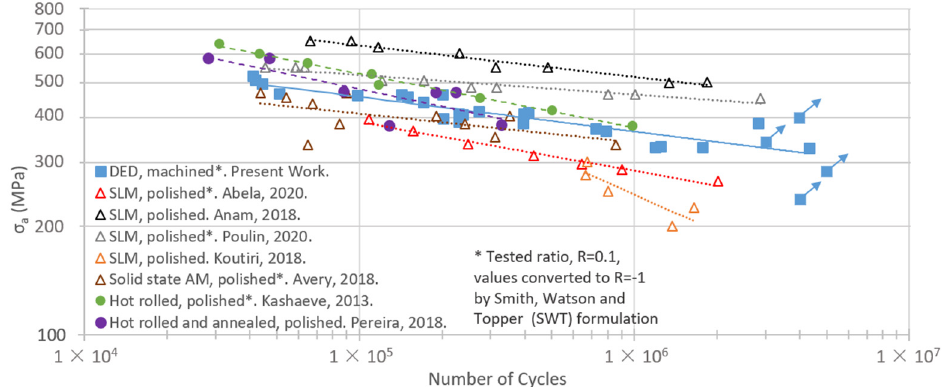
Figure 16. Literature comparison, S-N, R = − 1, data from [22], [23], [24], [25], [26], [27] and [13], respectively (according to the sequence presented in the chart legend).